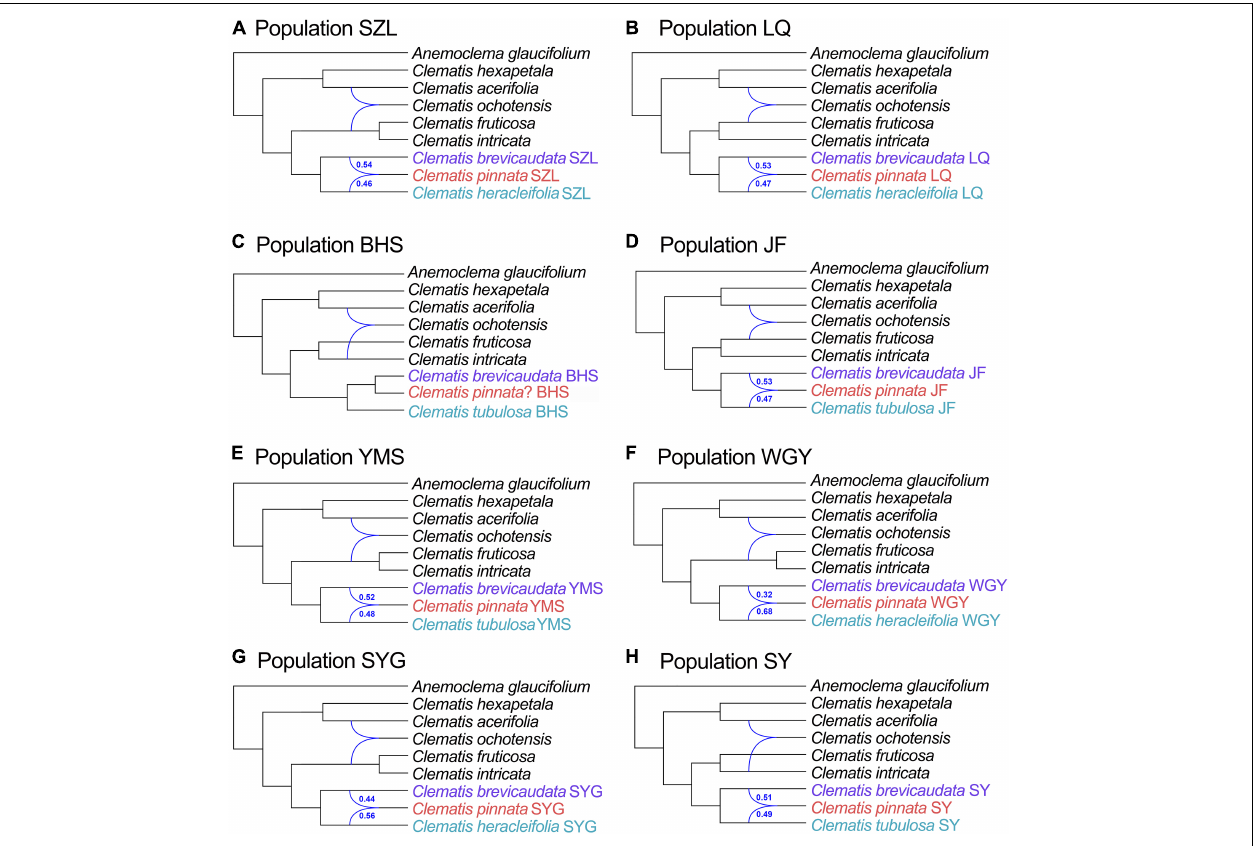
FIGURE 4 | Optimal species networks of all eight populations ( A-H , population abbreviations are explained in Table 2 ) of C. pinnata and its putative parents inferred by 3000 co-orthologous nuclear genes (at least 500 bp in length) using the PhyloNet. The results are maximum pseudolikelihood trees with a maximum of two reticulations. Genetic contributions of the putative parents estimated by HyDe analysis (using reduced SNP data) were marked beside the curve lines.